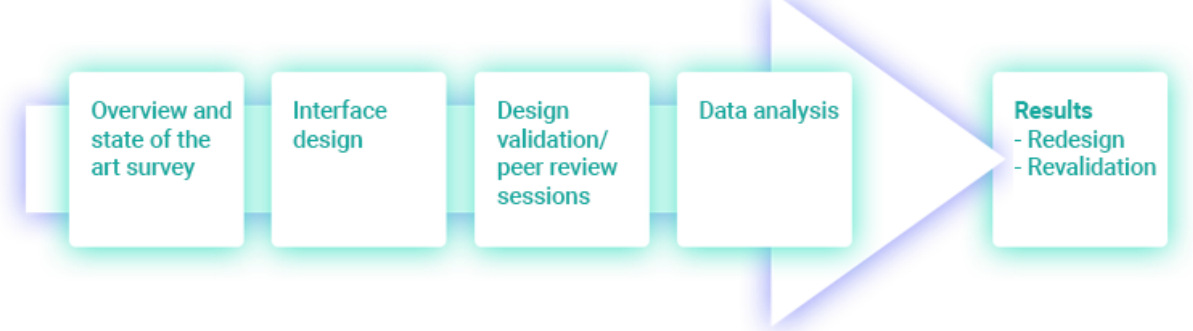
Figure 1. Design of the